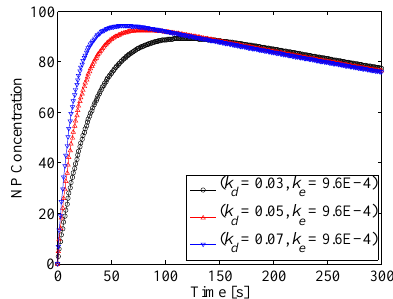
Figure 1: Nanoparticle concentration within the compartment model, for different values of the dis- solution constant. Higher the dissolution constant, faster the increase of